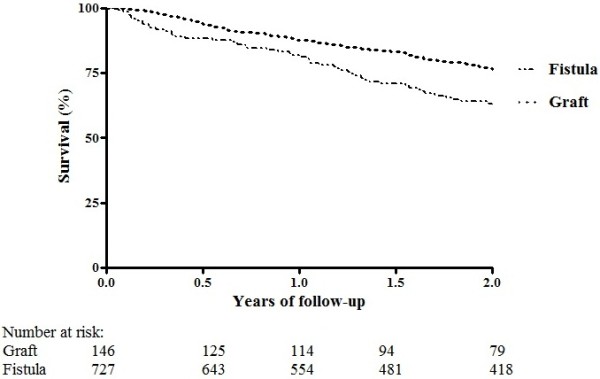
Kaplan-Meier survival curve for two-year mortality.